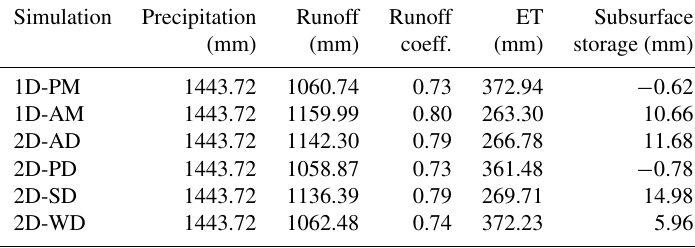
Table 2. Annual water budget terms in the catchment for different simulations. Simulation Precipitation Runoff Runoff